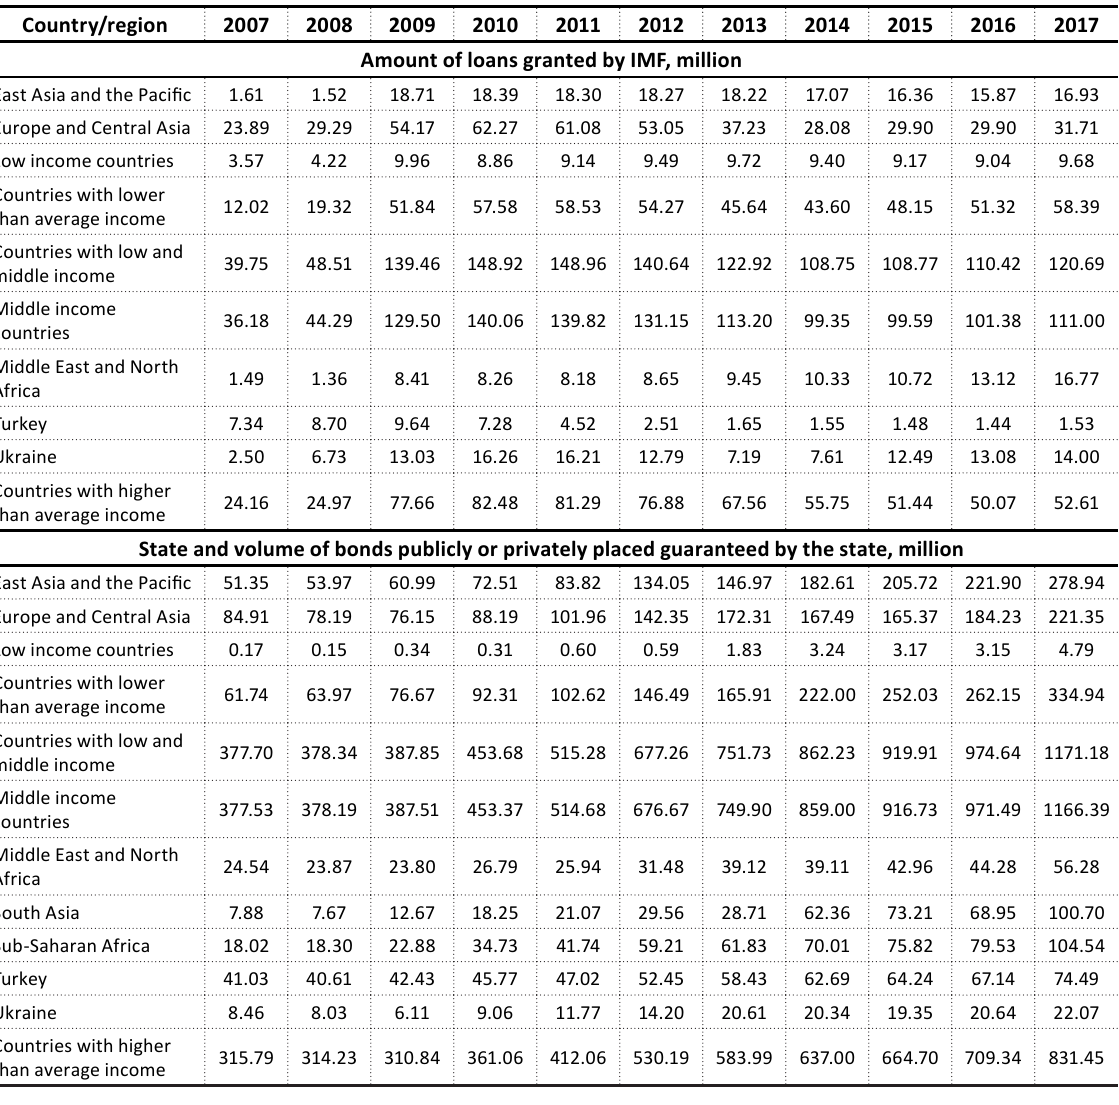
Source: The World Bank (n.d.a).